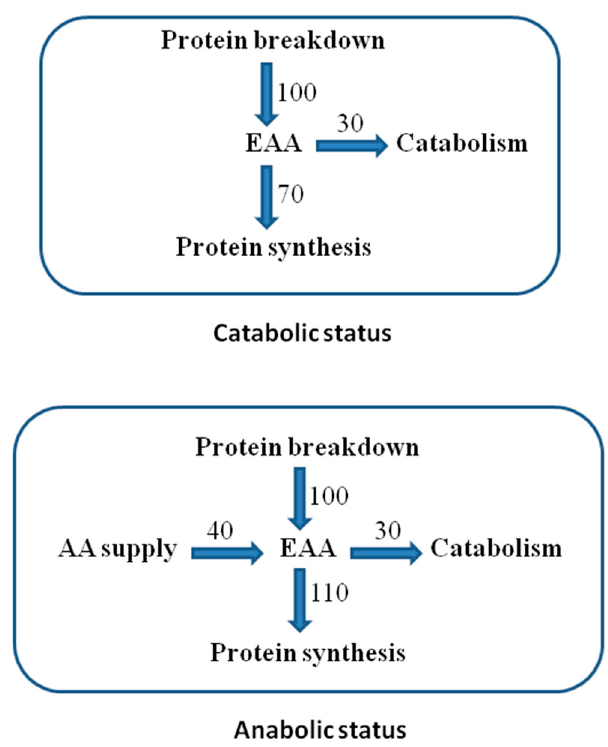
Figure 2. Essential AA (EAA) recycling in protein turnover. Reported units are arbitrary to explain the differences between the anabolic and catabolic states in the presence or absence of external AA supply.